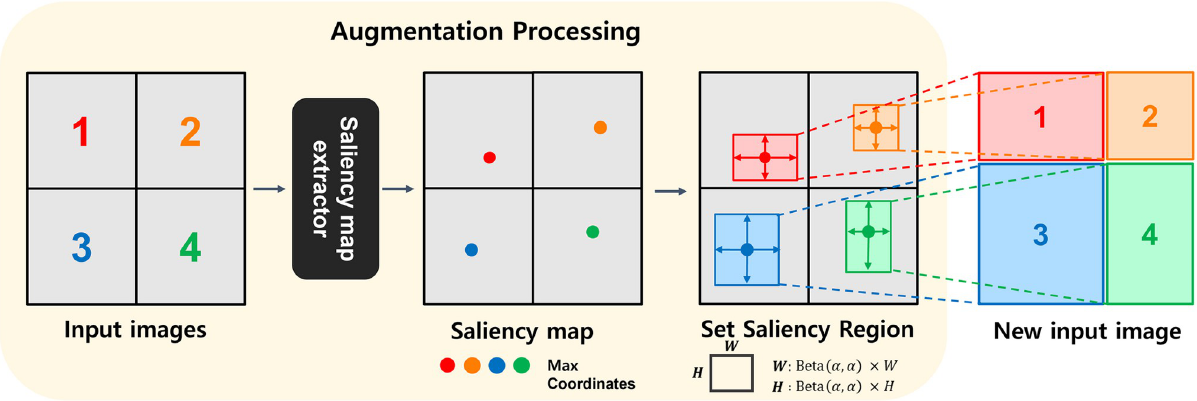
Fig 1. An overview of the proposed data augmentation